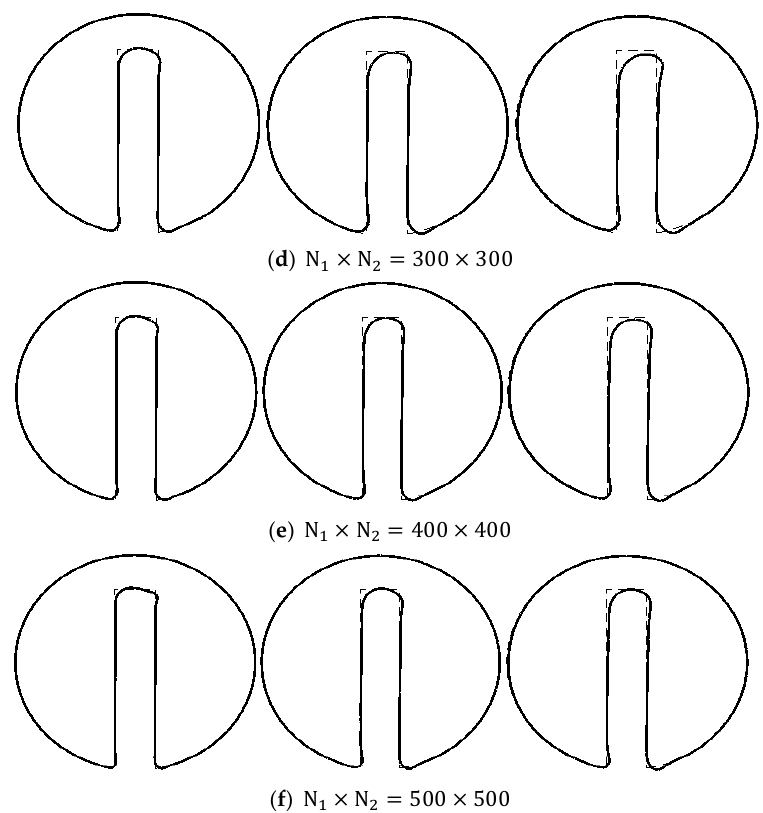
Figure 10. The Notched cylinder after first ( left picture), third ( middle picture), and fifth ( right picture) revolutions with different structured mesh spacing. The solid lines show the results after the evolutions and the dashed lines are the original notched cylinder.